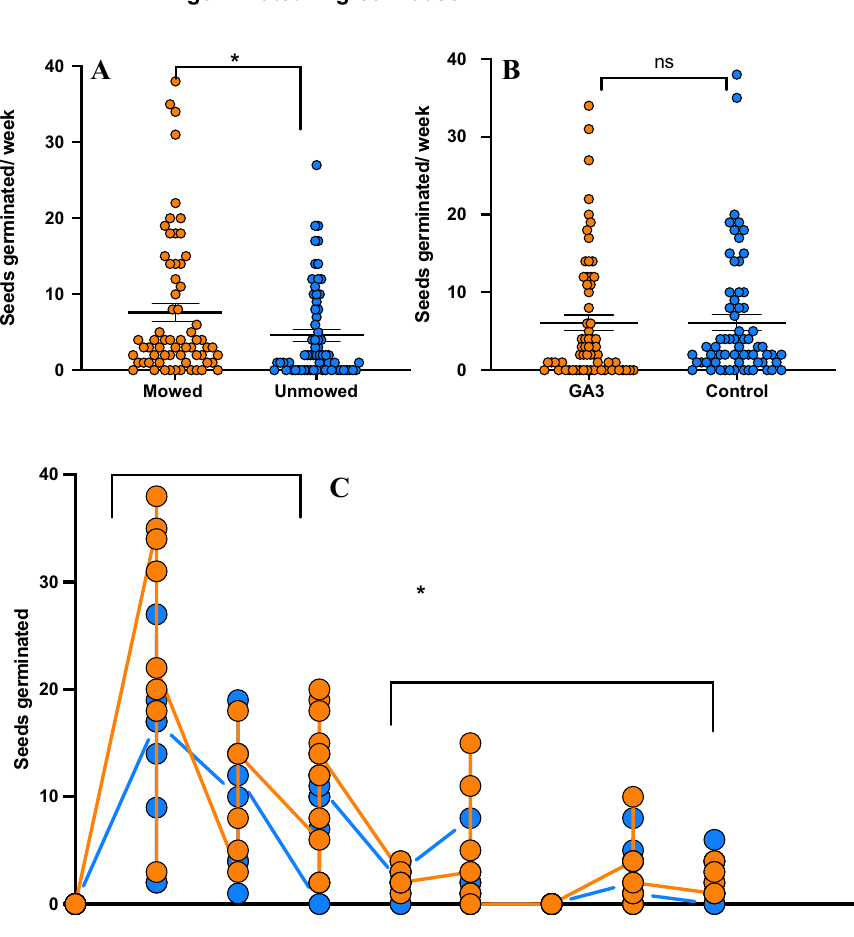
Figure 2. Results of seed germination in green house ( A ) seeds germinated per week on mowed and unmowed plants (P < 0.002), ( B ) seeds germinated per week with GA 3 treatment and control (P = 0.974), ( C ) Seeds germinated over time (early vs late season) (treatment P < 0.006; GA 3 P = 0.977), mowed and GA 3 (orange) and unmowed and control (blue) plants. Means are shown by scale bars and asterisk denotes significantly different results at P < 0.05, while ns denotes non-significant